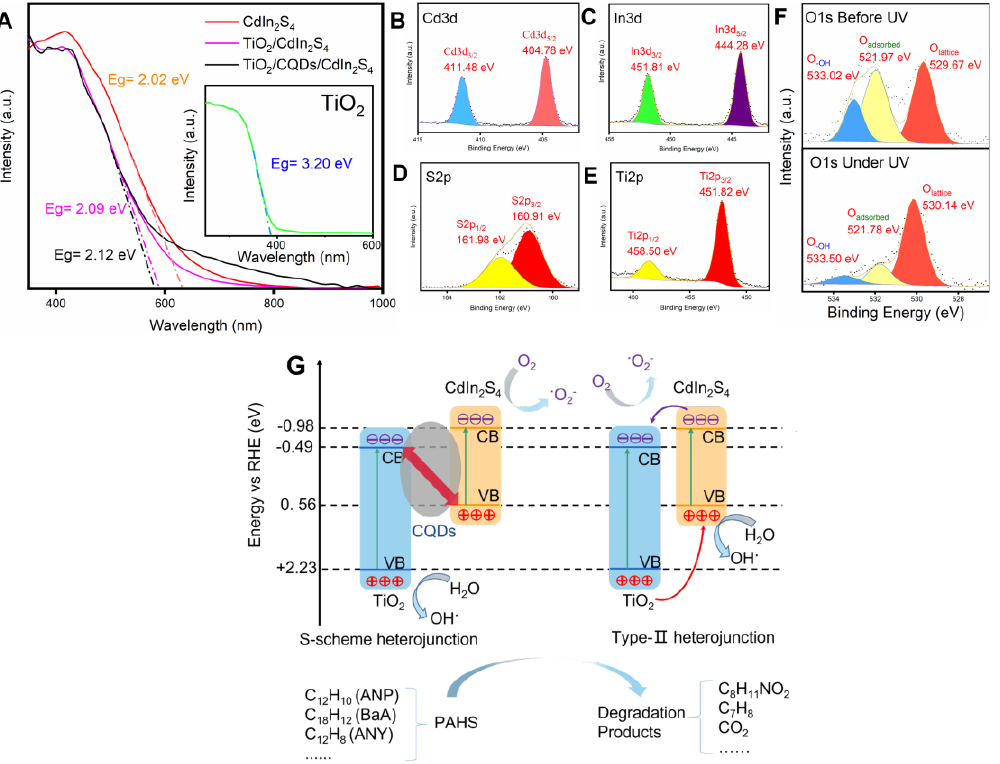
Figure 2. ( A ) UV-vis DRS of CdIn 2 S 4 , TiO 2 /CdIn 2 S 4 and TiO 2 /CQDs/CdIn 2 S 4 ; ( B – E ) XPS spectra of the main elements in TiO 2 /CQDs/CdIn 2 S 4 ; ( F ) In-situ XPS spectra of O1s orbital in TiO 2 /CQDs/CdIn 2 S 4 , the data was collected with/without 365 nm irradiation; ( G ) The band position and charge transfer of S-scheme photocatalytic reaction process of TiO 2 /CQDs/CdIn 2 S 4 and the type-II photocatalytic reaction process of TiO 2 /CdIn 2 S 4 under illumination.